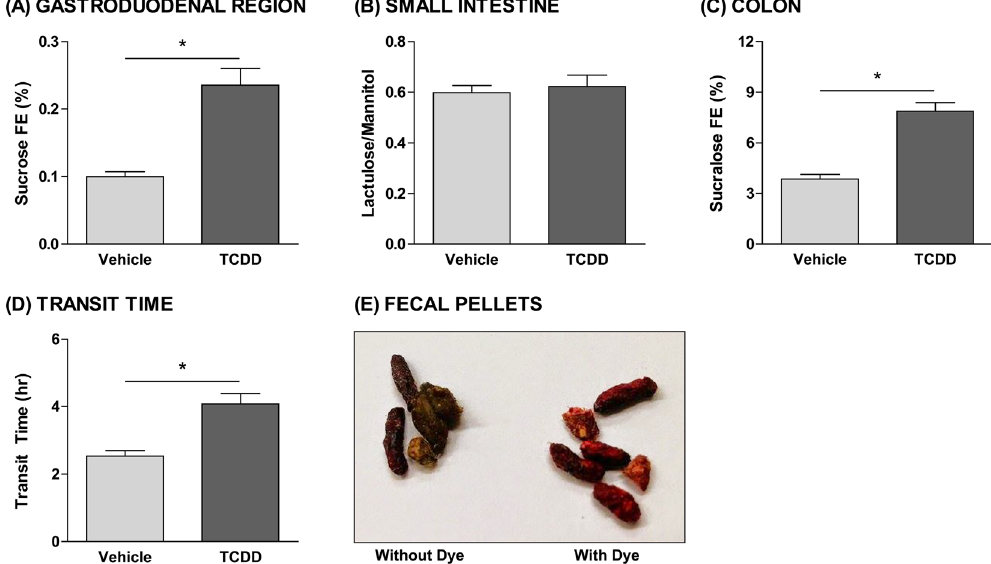
Figure 7. Effects of TCDD on intestinal permeability and motility. Para-cellular permeability of the ( A ) gastroduodenal region, ( B ) small intestine, and ( C ) colon in male C57BL/6 mice orally gavaged with sesame oil vehicle or 30 µ g/kg TCDD every 4 days. At 26 days after the initial dose, mice were orally gavaged with sucrose, lactulose, mannitol, and sucralose to assess segment-specific intestinal permeability. Urine was collected over a 5-hour period, and fractional excretion (FE) of the probes was measured using ultra high performance liquid chromatography (UPLC) tandem mass spectrometry (MS/MS). ( D ) Whole gut transit time of male C57BL/6 mice orally gavaged with sesame oil vehicle or 30 µ g/kg TCDD every 4 days. At 27 days after the initial dose, transit time was monitored by orally gavaging mice with Carmine Red and then measuring the interval between the gavage and the first observance of dye in the fecal pellets. ( E ) Fecal pellets collected from mice following oral gavage with Carmine Red dye (right) compared to pellets lacking the dye (left). Bars represent the average ± standard error of the mean for at least 6 biological replicates. Statistical significance ( * p ≤ 0.05) was determined using a Student’s t-test performed in SAS